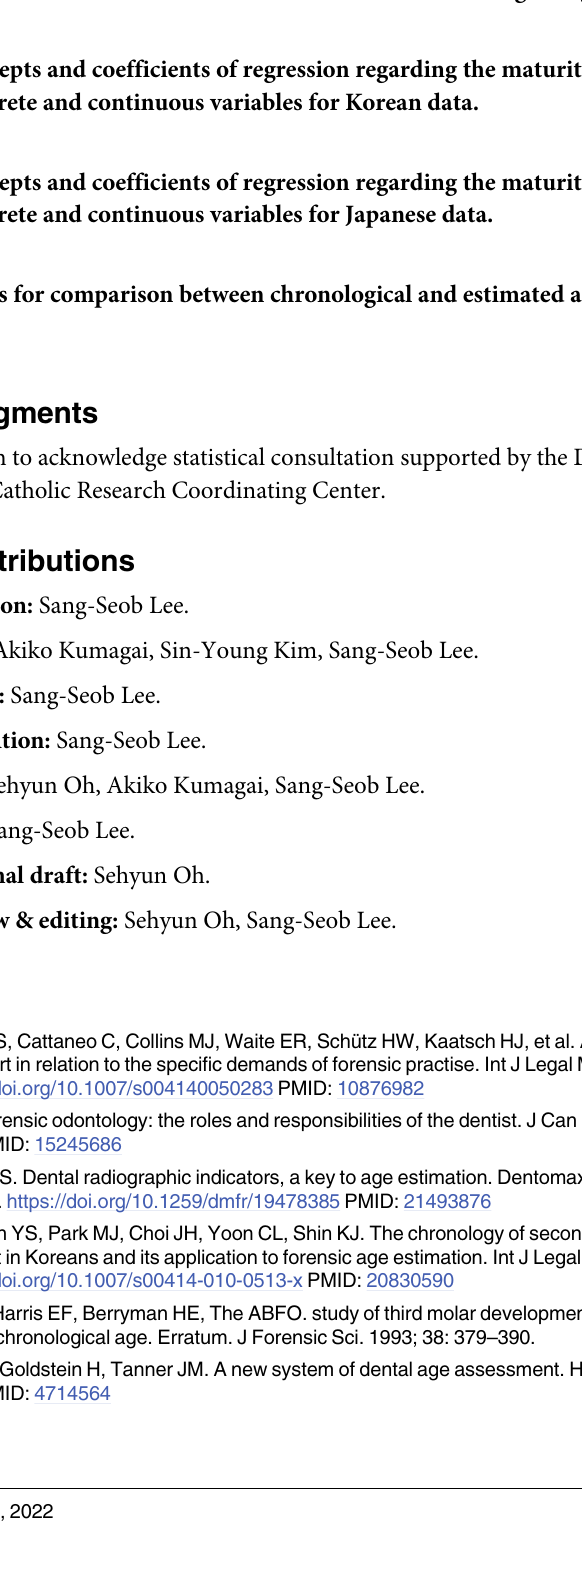
S1 Table. Median and interquartile range of estimated ages according to chronologic age group. S2 Table. Correlation coefficient between estimated and chronological age. S3 Table. Intercepts and coefficients of regression regarding the maturity stages of M2s and M3s as discrete and continuous variables for Korean data. S4 Table. Intercepts and coefficients of regression regarding the maturity stages of M2s and M3s as discrete and continuous variables for Japanese data. S1 Fig. Box plots for comparison between chronological and estimated